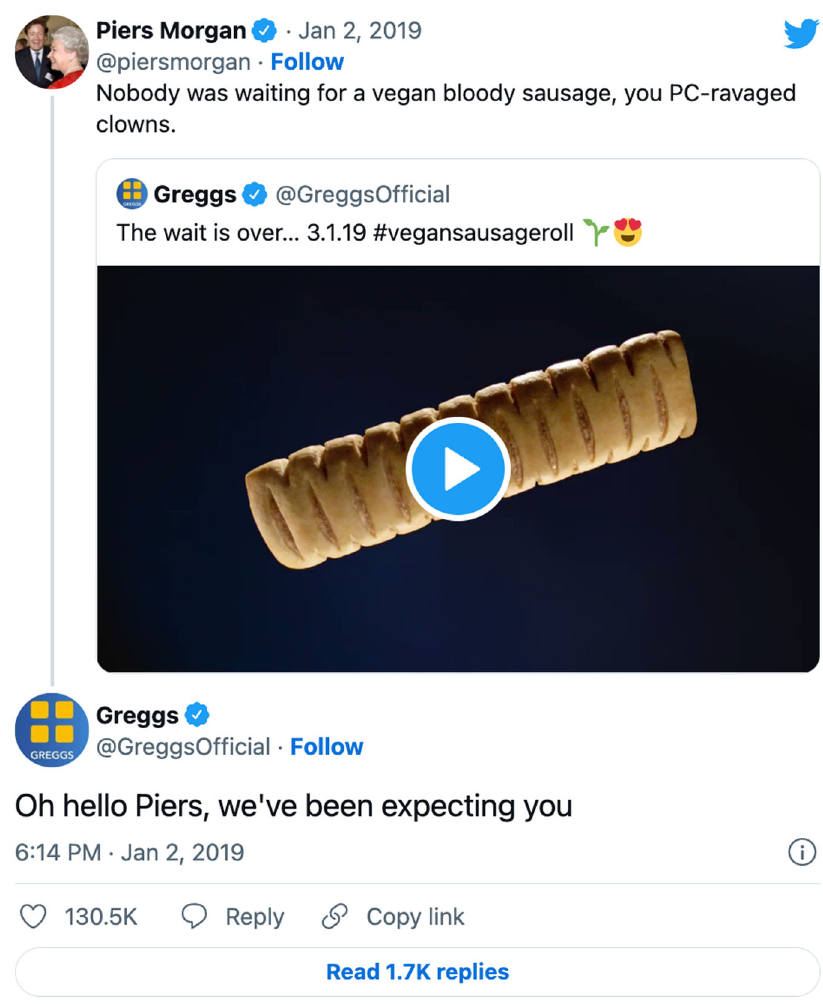
Fig. 1 Initial tweet exchange between Piers Morgan and Greggs. A screenshot, taken by the authors, of the post in which Greggs announced the launch of the vegan sausage roll with Morgan ’ s initial reply and Greggs ’ counter